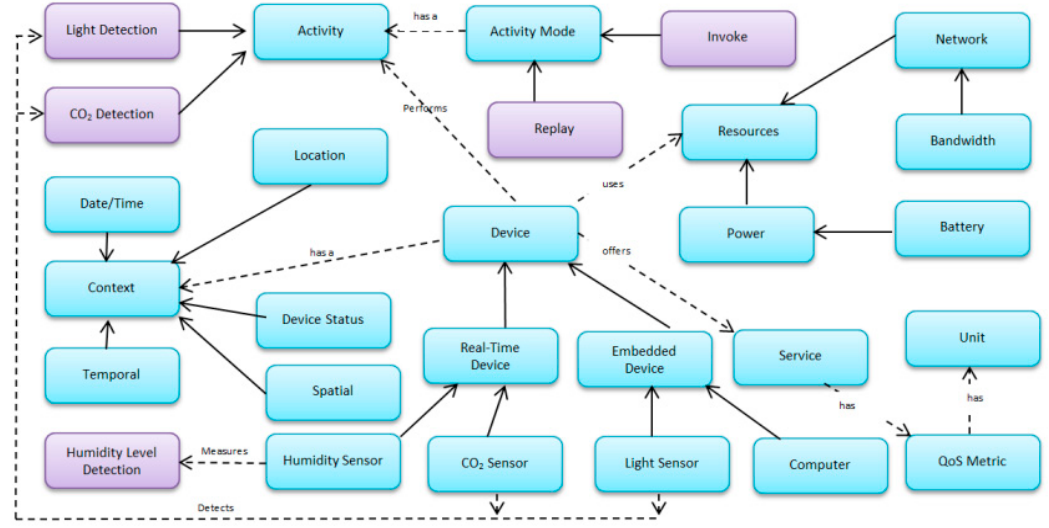
Figure 2. Context and mobile robot ontologies mapping.